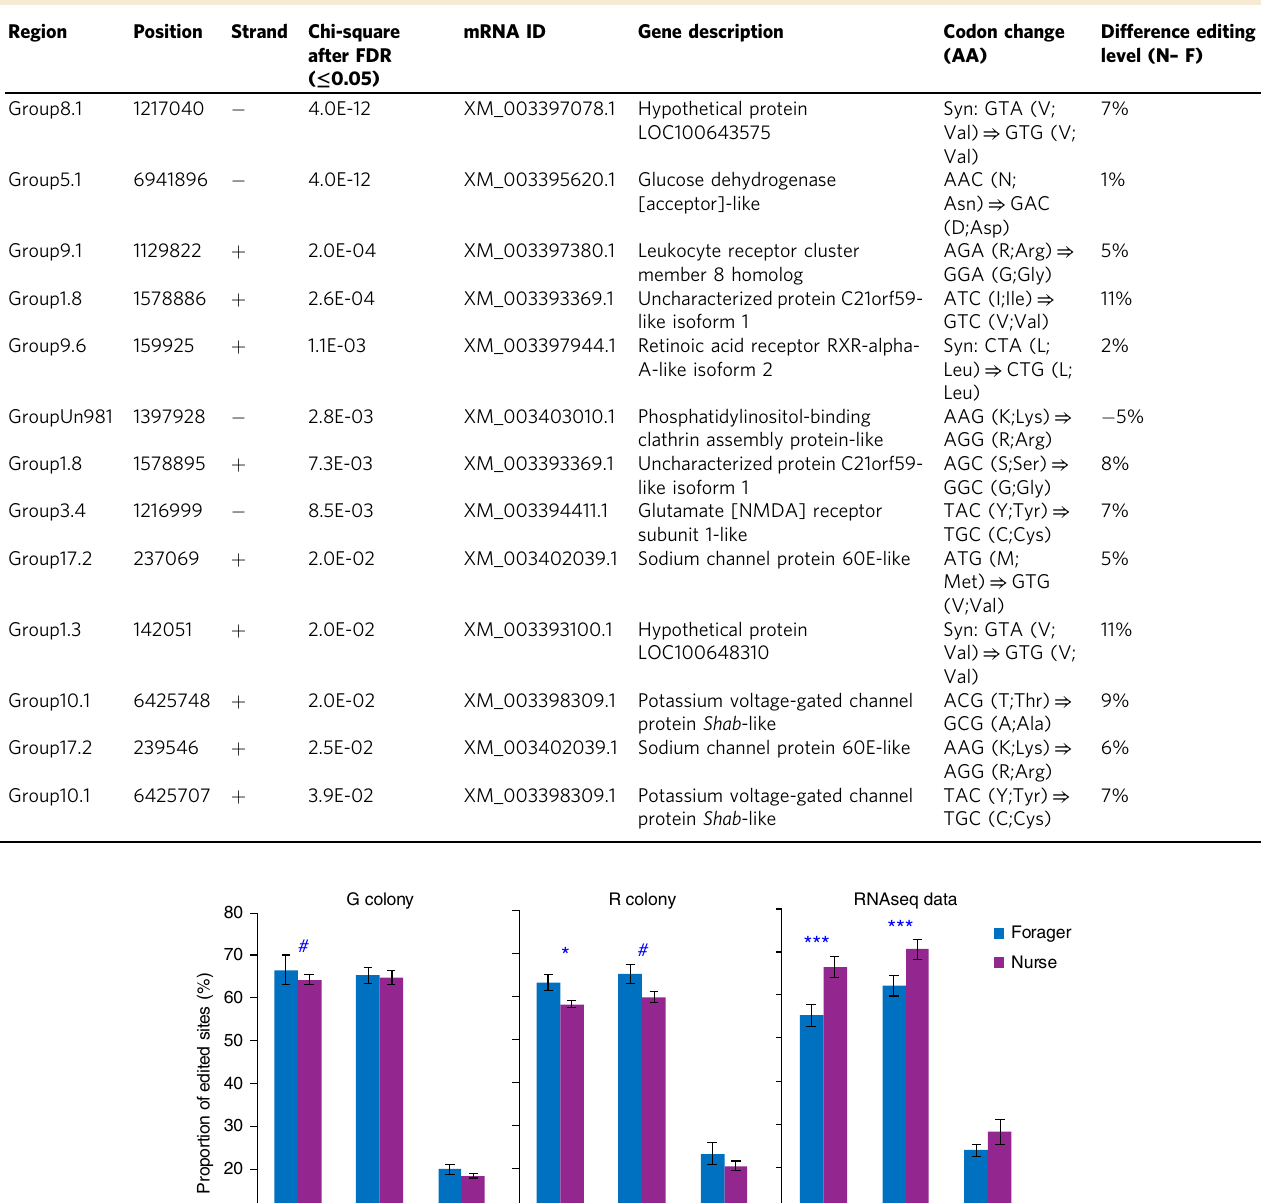
Table 3 Differential task-related editing in protein coding sites